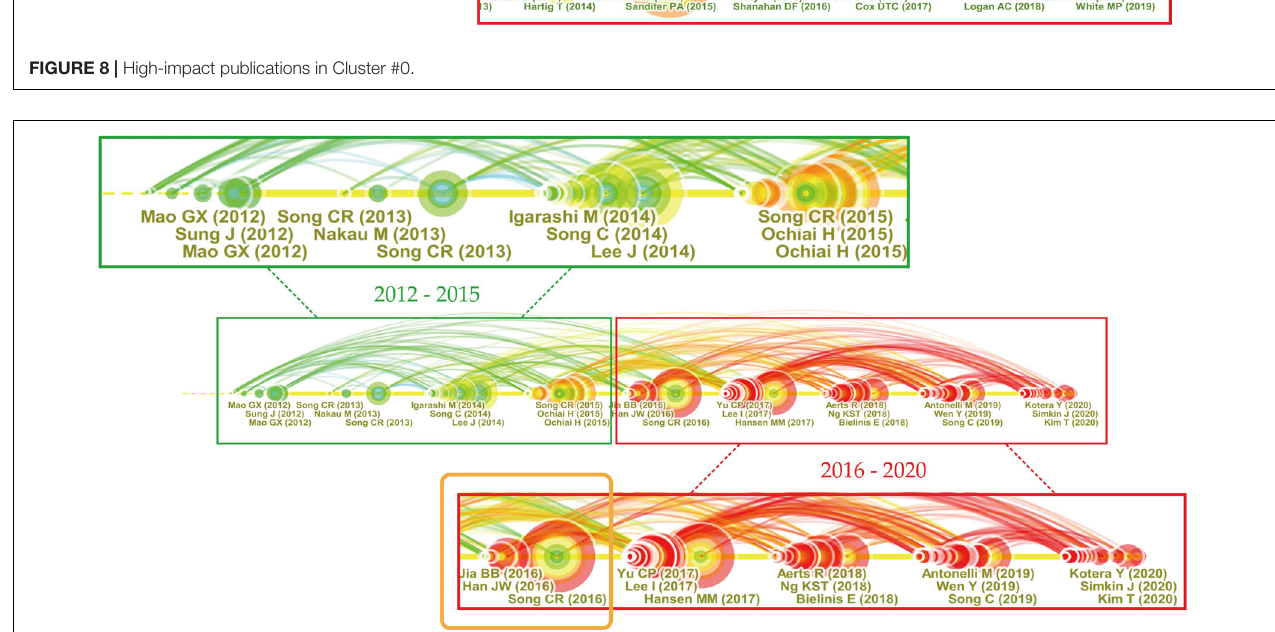
FIGURE 9 | High-impact publications in Cluster